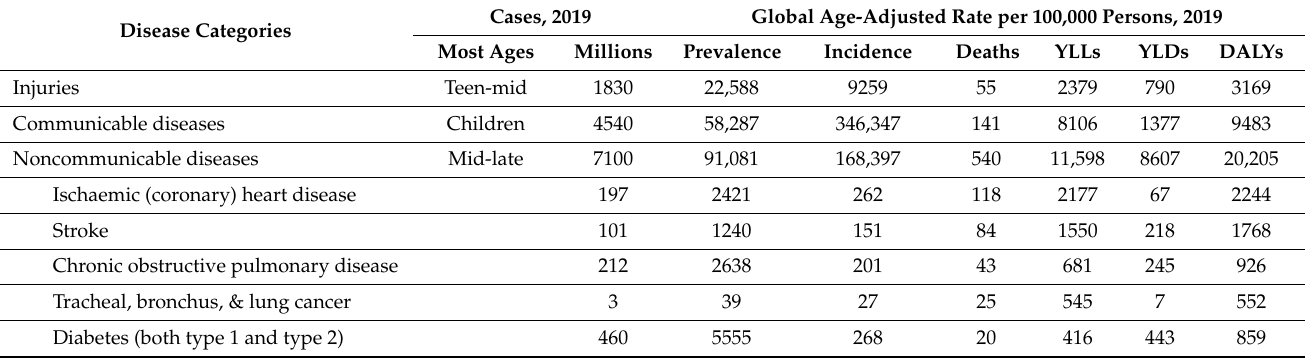
Table 2. Global burden of disease in 2019 by different metrics for the three broad categories of death (GBD level 1 causes) and the five NCDs with the highest death rates (GBD level 2